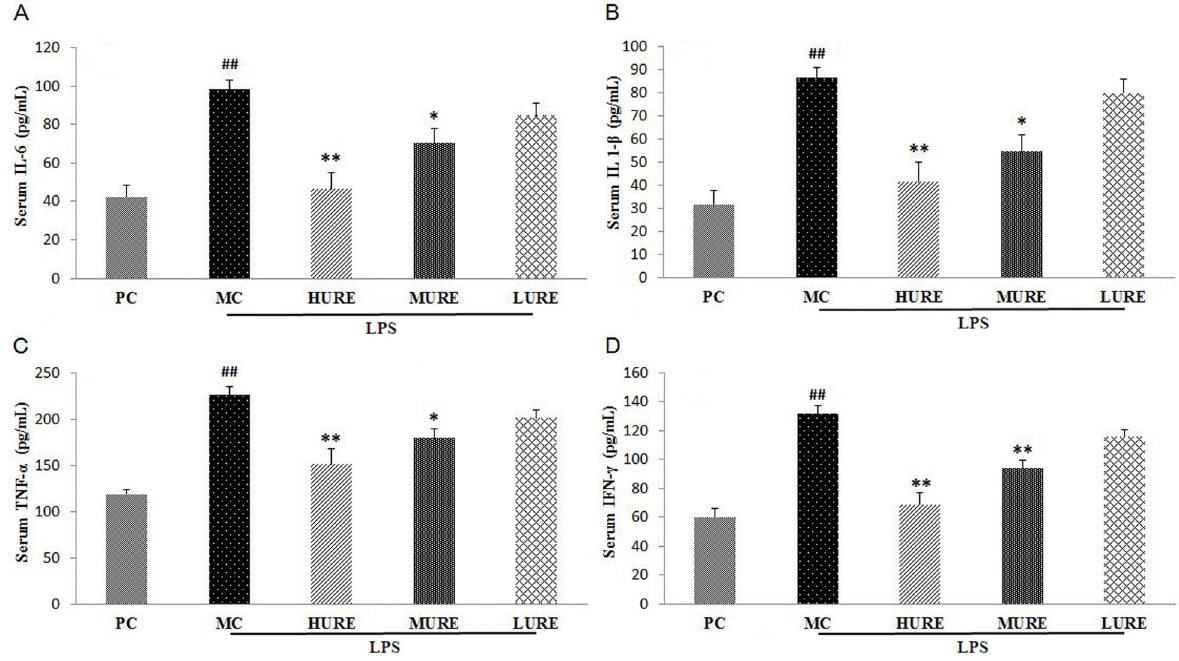
Figure 5. Serum levels of in fl ammatory cytokines in different groups on gestational day 20. Serum levels of interleukin (IL)-6 ( A ), IL 1- b ( B ), tumor necrosis factor (TNF)- a ( C ), and interferon (IFN)- g ( D ) were signi fi cantly higher in the MC group and lower in the Uncaria rhynchophylla alkaloid extract (URE) group. Data are reported as means ± SE (n=8/group). ## P o 0.01 vs PC group, *P o 0.05 and **P o 0.01 vs MC group (ANOVA). PC: pregnant control group; MC: LPS-treated group; HURE: LPS plus high-dose URE; MURE: LPS plus medium-dose URE; LURE: LPS plus low-dose